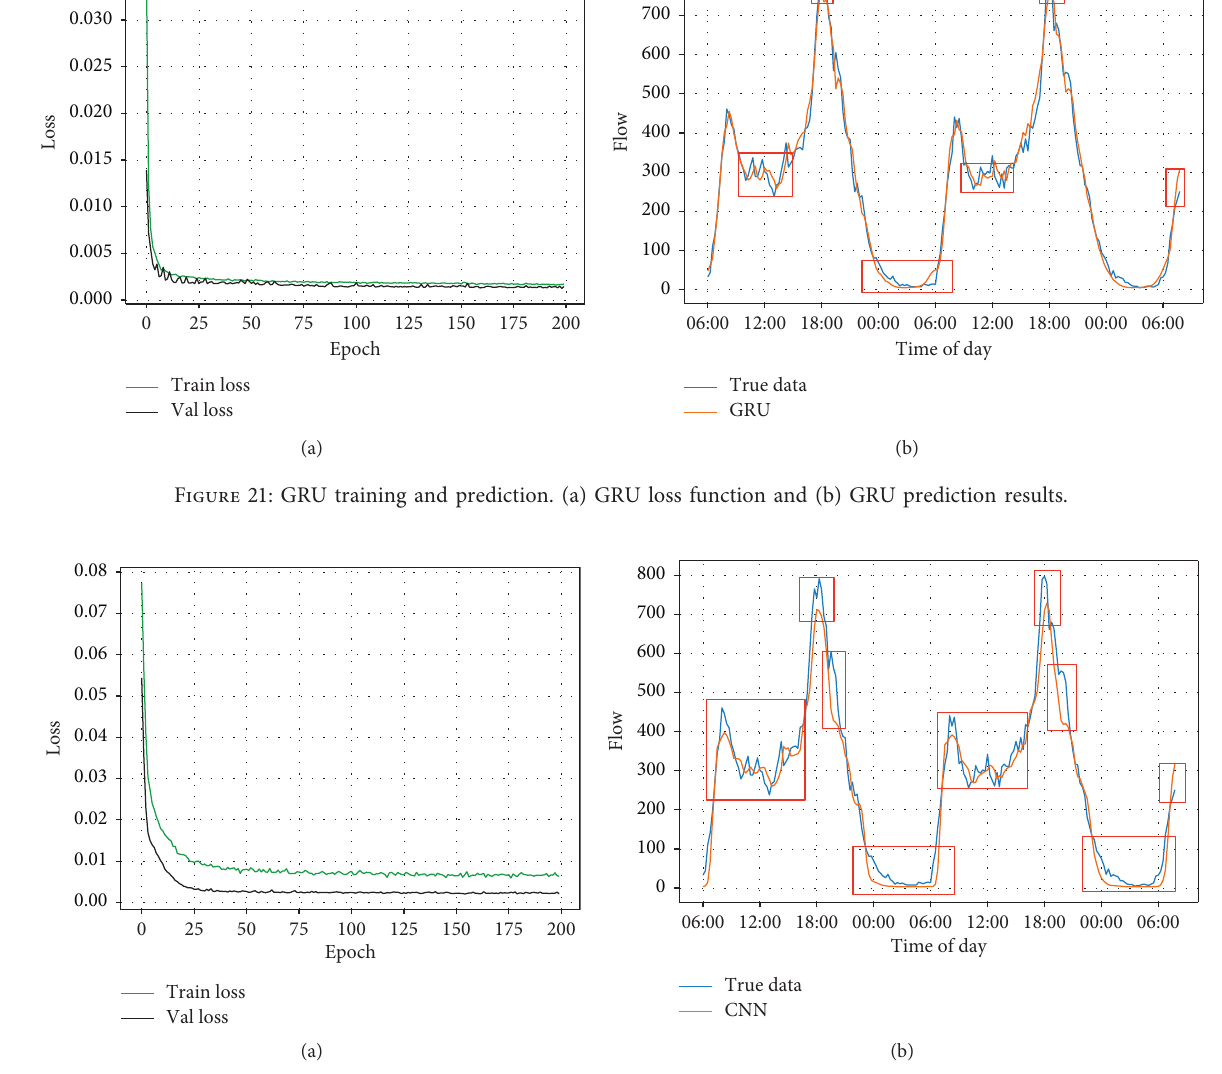
Figure 22: CNN training and prediction. (a) CNN loss function and (b) CNN prediction results.